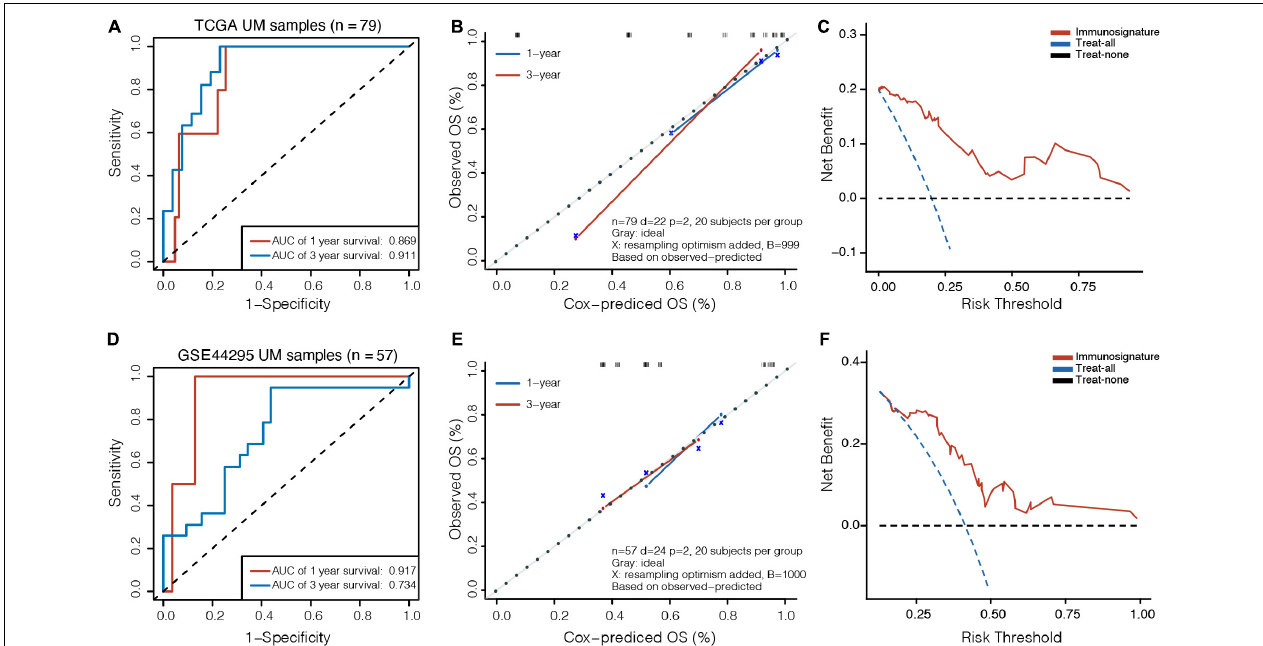
FIGURE 3 | Validation of prognostic model in UM. (A) Time-dependent receiver operating characteristic (ROC) curves, (B) calibration plots, and (C) decision curve analysis (DCA) for the OS predicted with the prognostic model in the TCGA cohort. (D) Time-dependent ROC curves, (E) calibration plots, and (F) DCA for the OS predicted with the prognostic model in the GSE44295 cohort. The x -axis of calibration plot is the immunosignature-predicted probability of OS, and the y -axis is the actual OS.